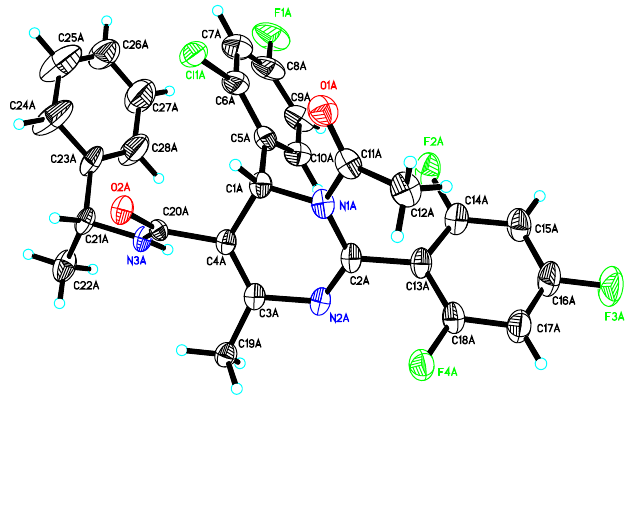
Figure 2. X-ray crystal structure of the intermediate 5